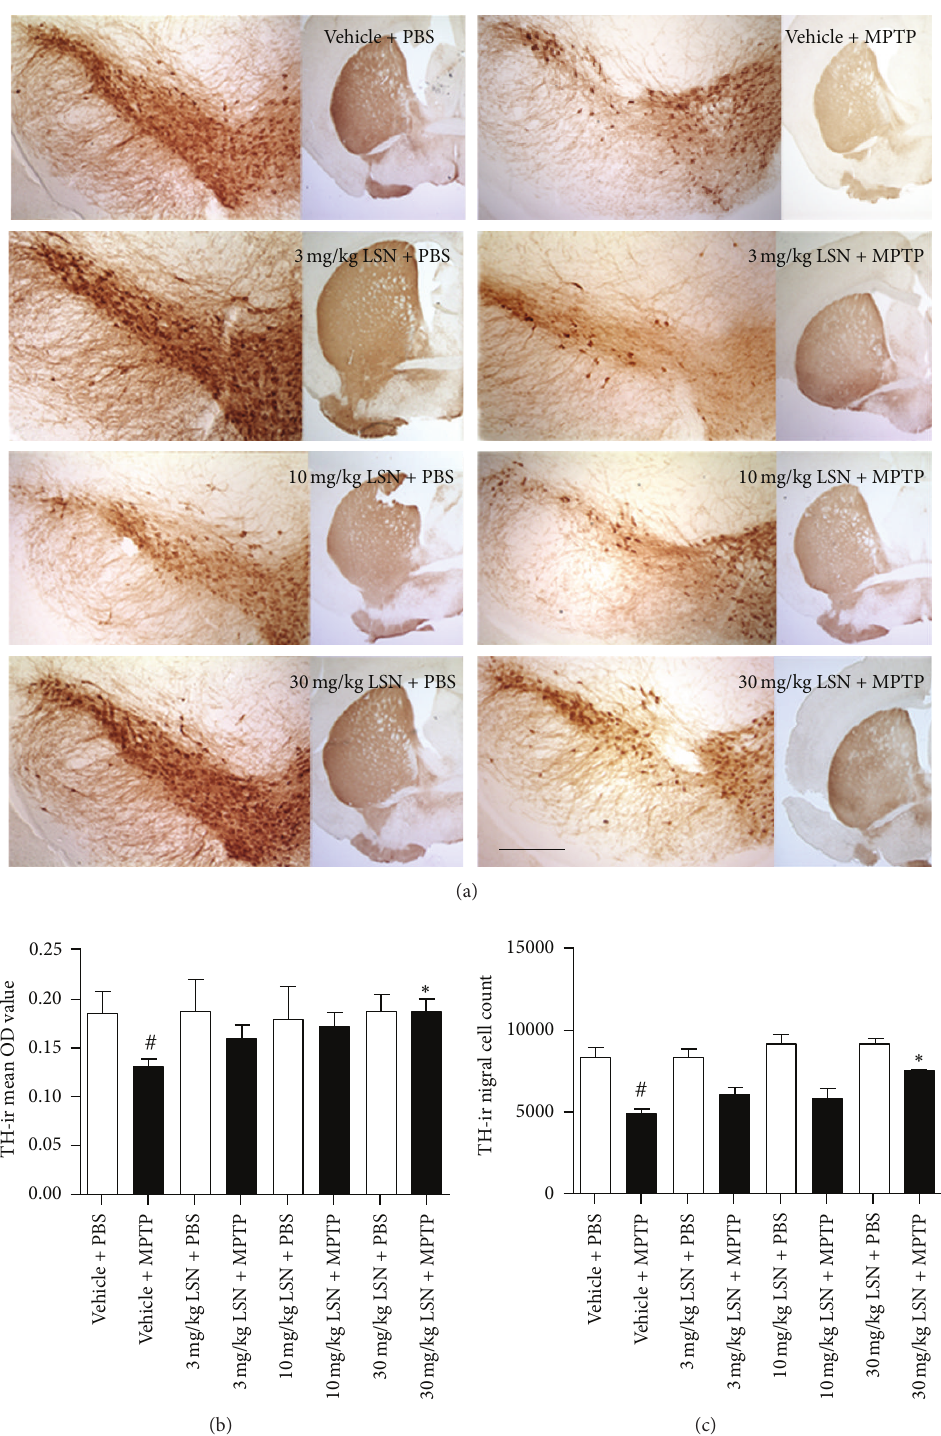
Figure 1: LSN862 (LSN) conferred neuroprotection against MPTP nigrostriatal loss in a dose-dependent manner. Mice brains were